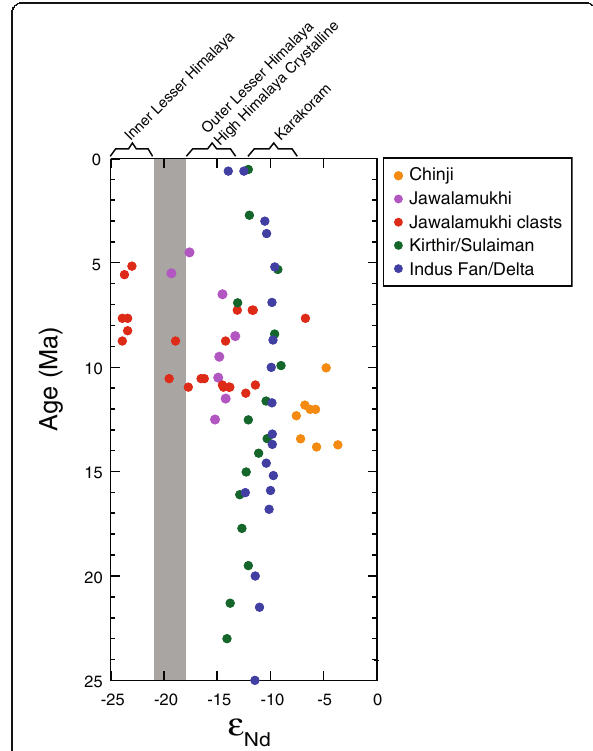
Fig. 7 Compilation of clastic sediment Nd isotope character from the Indus Basin since 25 Ma. Data from the Indus Shelf (Clift and Blusztajn 2005) and from the lower reaches in the Kirthir and Sulaiman Ranges (Zhuang et al. 2015) show a long term slow trend to more positive ε Nd values followed by a drift to more negative ε Nd values since ~5 Ma. In contrast, data from Chinji near the trunk Indus has consistently more positive ε Nd reflecting the primitive sources in the suture zone (Chirouze et al. 2015). At Jawalamukhi in the eastern part of the drainage, ε Nd values are more negative than the average. Extremely negative conglomerate clasts appear after ~9 Ma indicating erosion from the Inner Lesser Himalaya (Najman et al. 2009). Gray shading shows the demarcation between the Inner Lesser Himalaya and the Greater Himalayan Crystallines, Outer Lesser Himalaya and